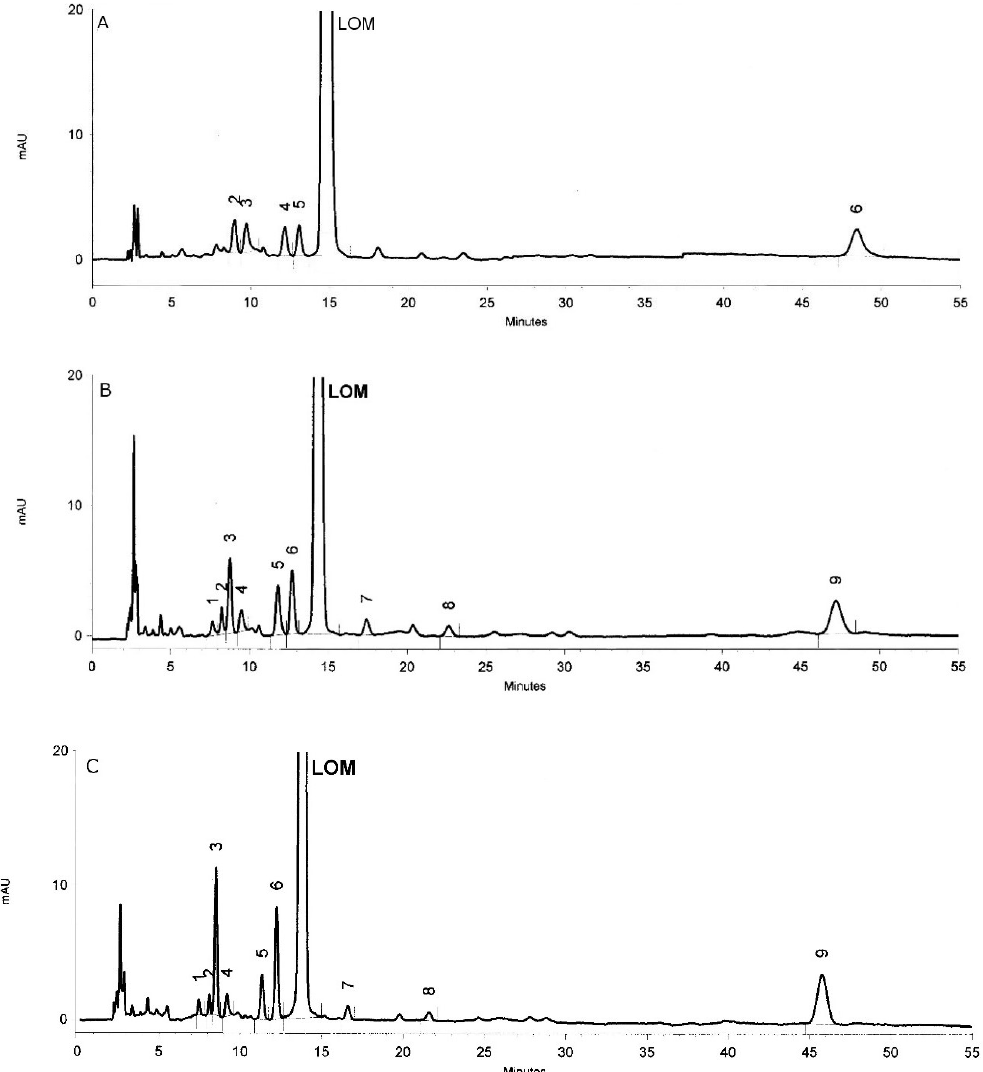
Figure 6. Chromatograms of water solution of LOM after oxidation by ACVA: ( A )—40 °C and 96 h of incubation, ( B )—50 °C and 72 h of incubation, ( C )—60 °C and 36 h of incubation.